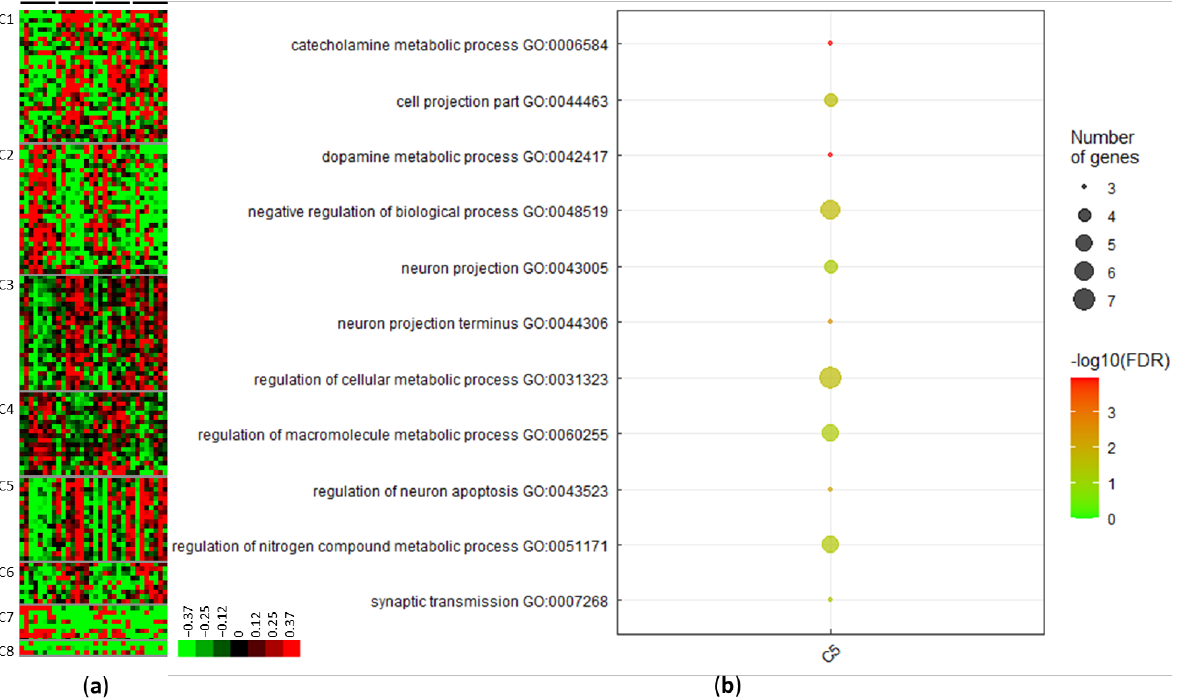
Figure 3. Proteins differentially expressed with acute mild stress ( n = 138). ( a ) Unsupervised Bayesian clustering for the four groups ( n = 8/group): control non-stressed (C-NS), control stressed (C-S), fish hydrolysate non-stressed (FH-NS), fish hydrolysate stressed (FH-S). ( b ) Gene ontology (GO) term enrichment for proteins upregulated with stress from cluster C5. Table 3. Pathways and associated proteins upregulated by acute mild stress.